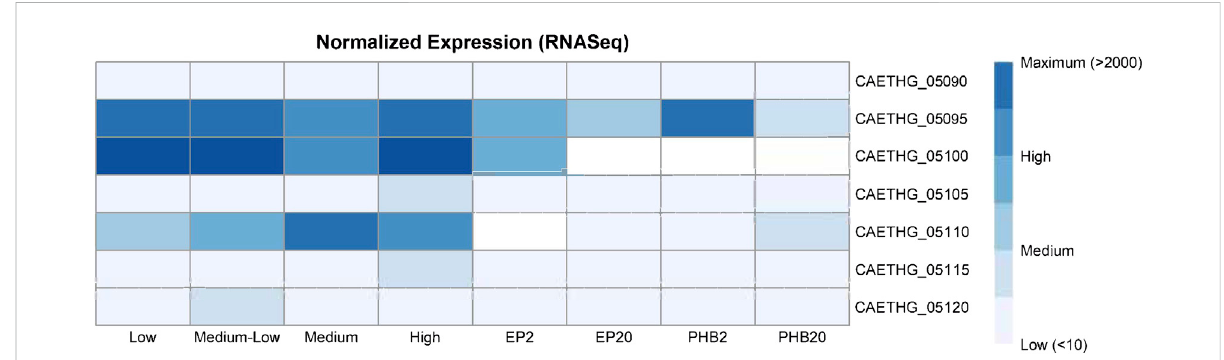
FIGURE 4 Expression of plasmid genes in the published RNASeq data. Normalized (FPKM) and mean expression of the plasmid genes corresponding to varying biomass concentration (low, medium-low, medium, and high), and recombinant poly-3-hydroxybutyrate (PHB) and empty plasmid (EP) strains grown using syngas (20% H 2, denoted in sample label by 20) or steel mill off-gas (2% H 2 denoted in sample label by 2). See original articles for details (Table 1).